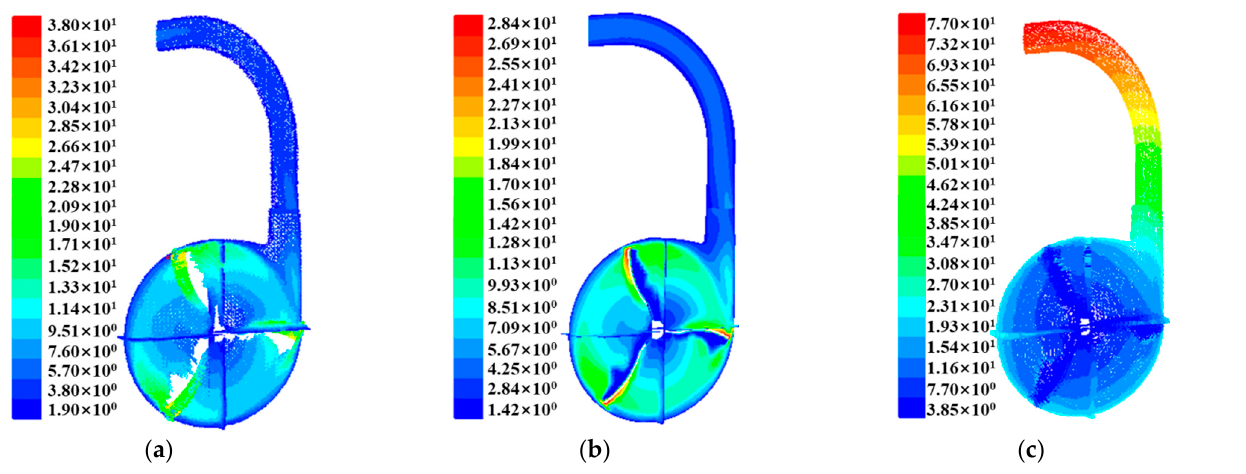
Figure 12. Speed distribution diagram in the device. ( a ) The velocity vector diagram of the crushed straw material phase. ( b ) The velocity cloud diagram of crushed straw material phase. ( c ) The relative velocity vector diagram between the crushed straw material phase and the air phase.